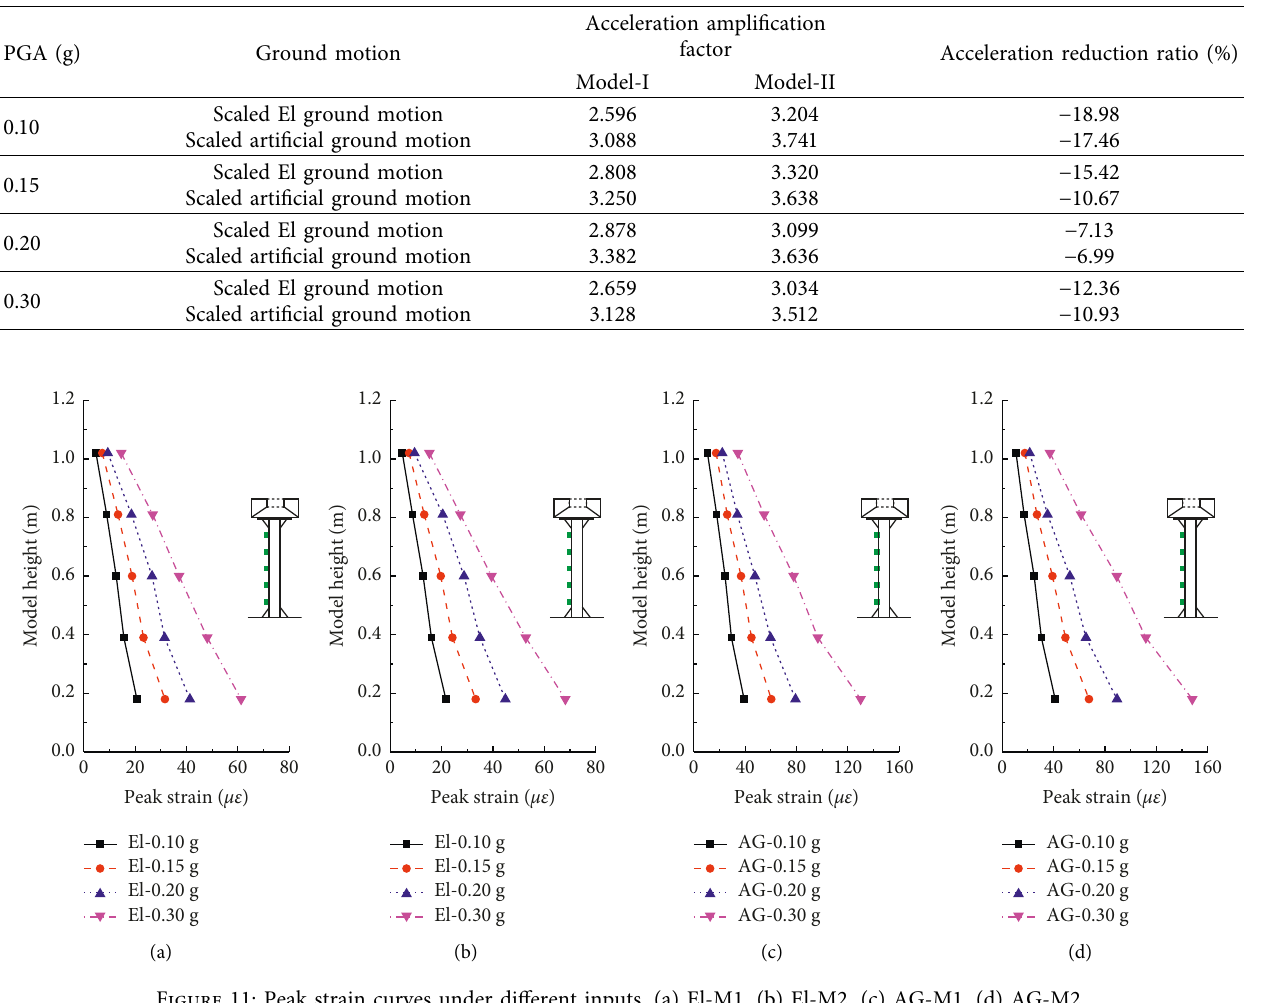
Table 6: Comparison of acceleration amplification factors.